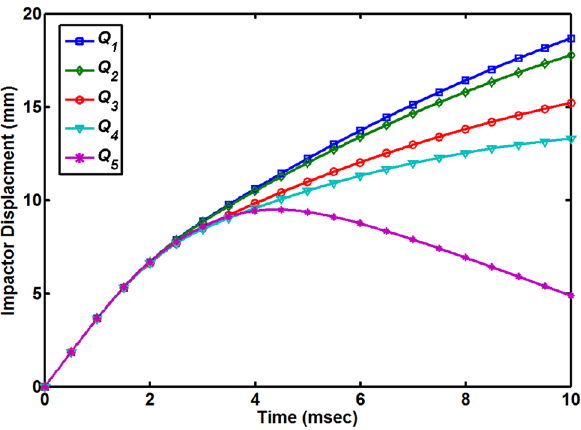
Figure 5. Impactor displacement versus time diagram for all quasi-isotropic composite plates.